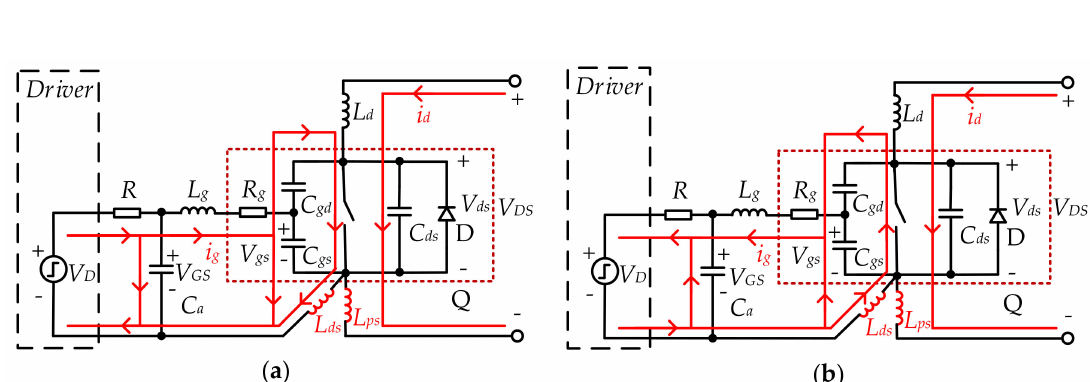
Figure 6. The current flow of general 4-pin SiC MOSFET during switching: ( a ) Turn-on process, ( b ) Turn-o ff